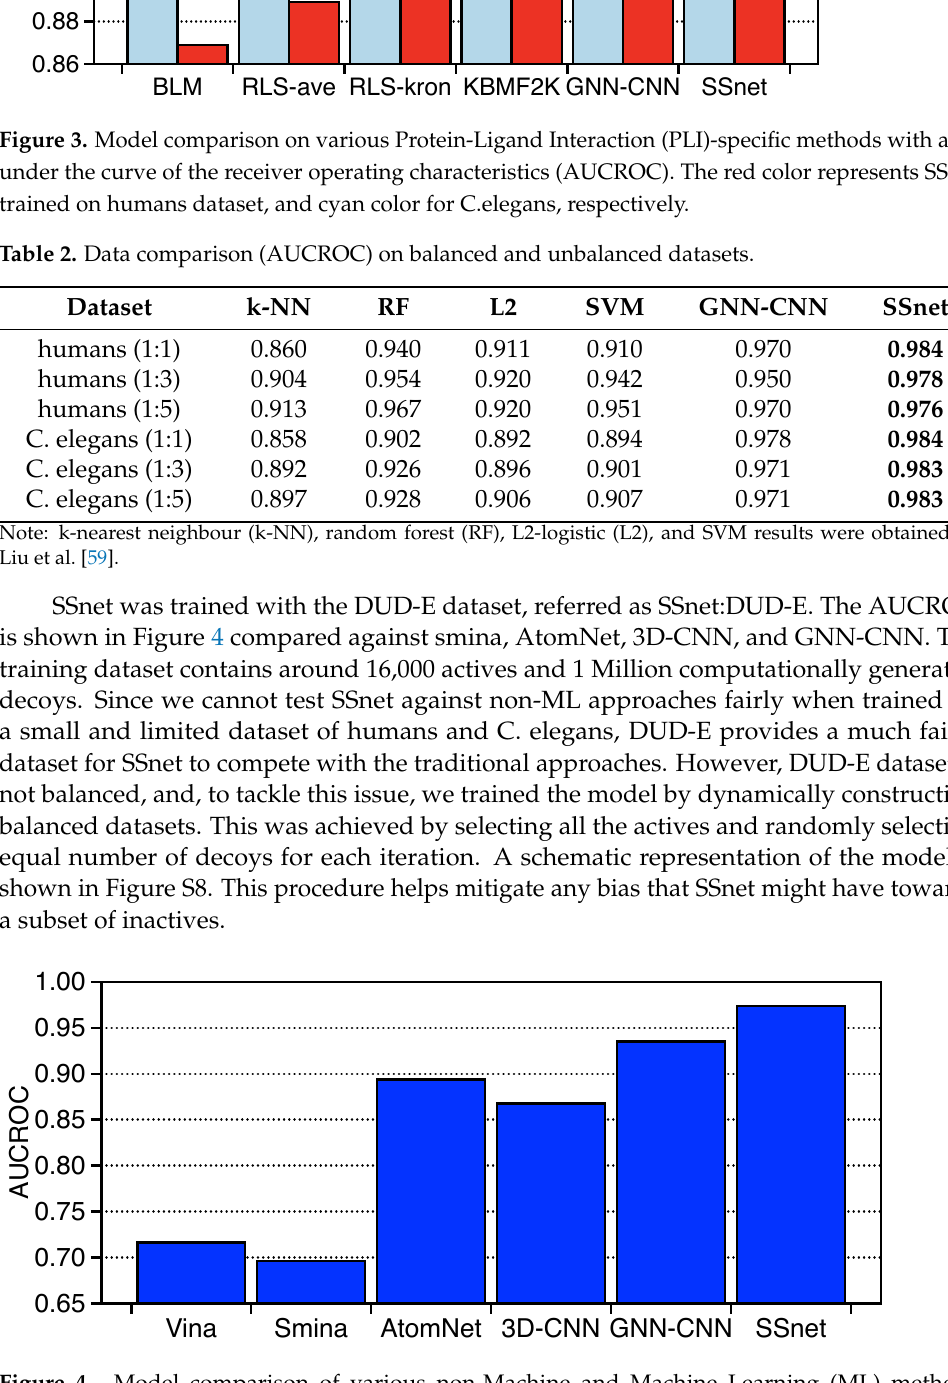
Figure 4. Model comparison of various non-Machine and Machine Learning (ML) methods for the DUD-E dataset. The AUCROC score for the methods mentioned are derived from the literature [26,27,63]. SSnet here is trained on the DUD-E